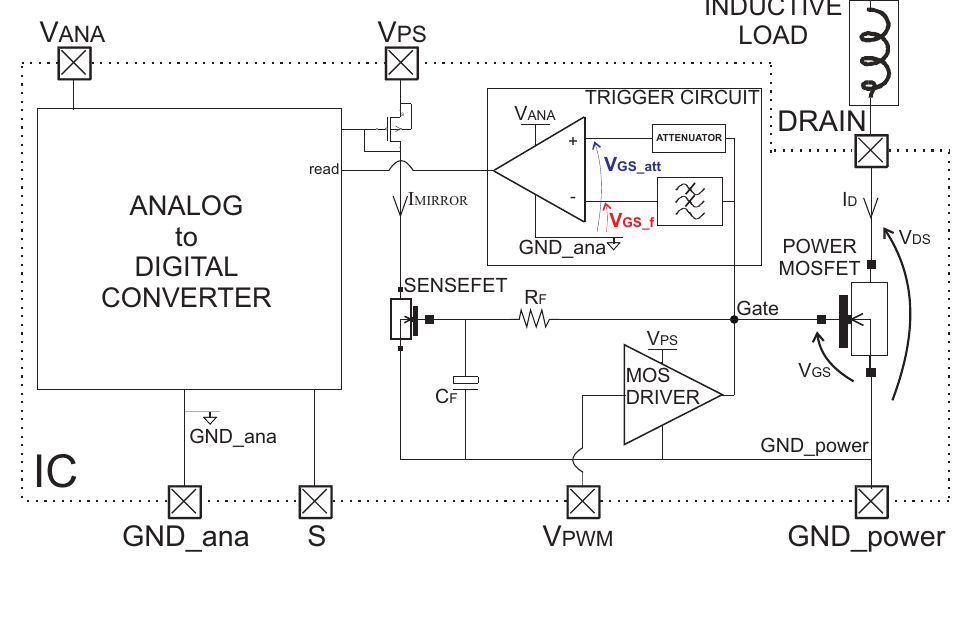
Figure 4. Block diagram of the proposed current sensor that exploits the Miller